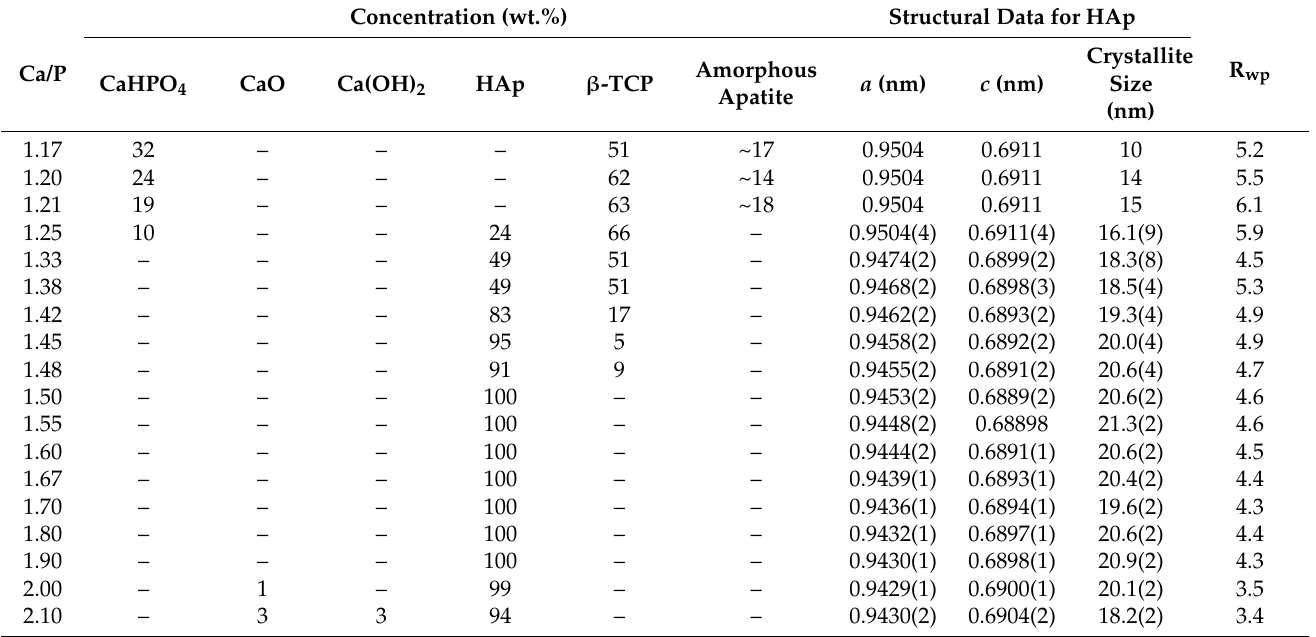
Table 2. Phase composition and structural data of the HAp phase in the synthesized